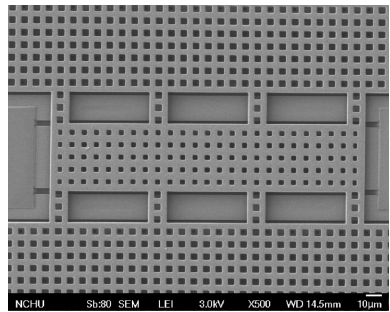
Figure 11. Optical image of the micromachined switch.